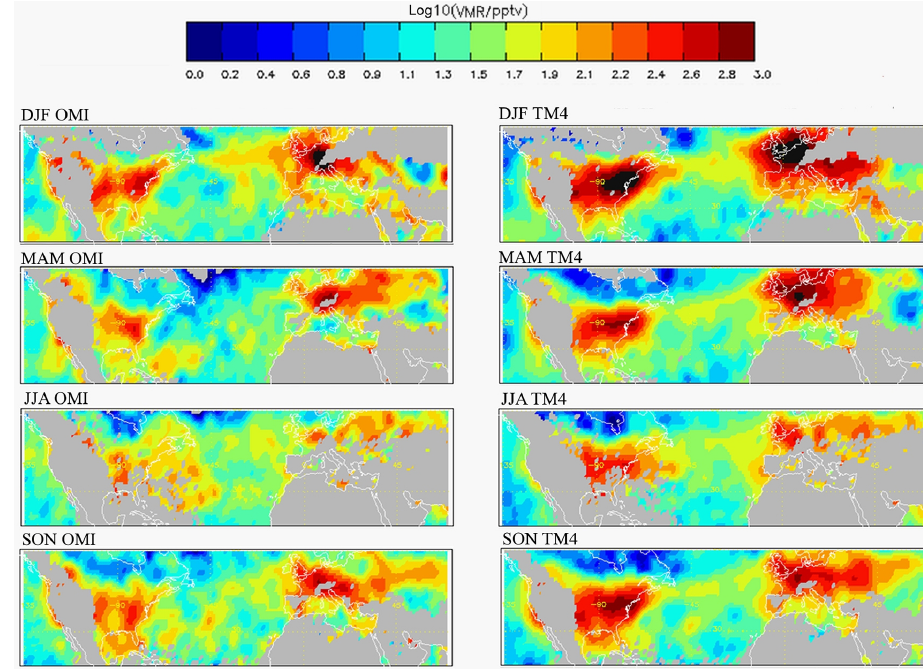
Figure 33. Same as Fig. 29 but at 820hPa in logarithmic